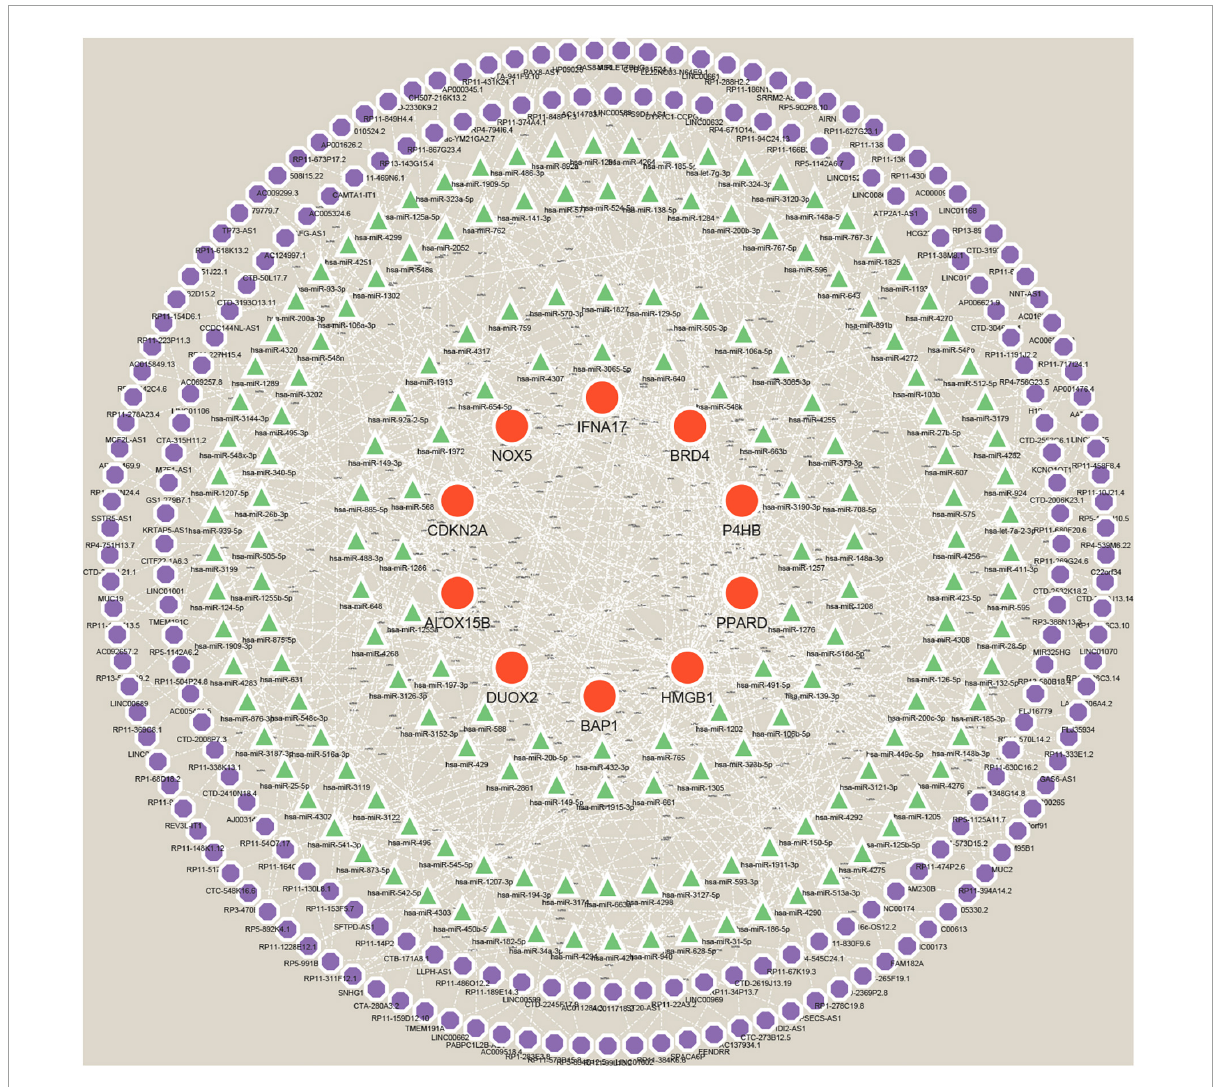
FIGURE12 A ceRNA networks based on Hub genes. The network includes 388 nodes (10 mRNAs, 169 miRNAs, 209 lncRNAs), 503 edges. Red orbs represent Hub genes, green triangles represent miRNAs, and purple orbs represent lncRNAs.